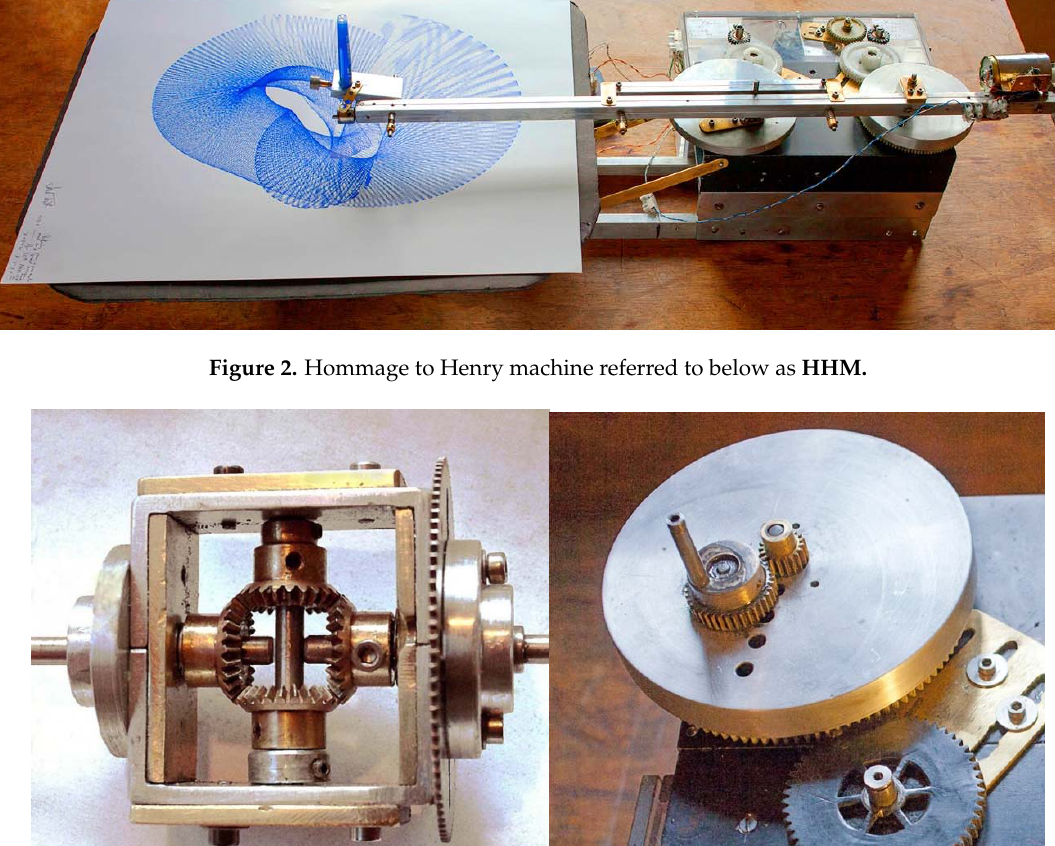
Figure 4. X:Y configuration, sun and planet on the left, elliptical turntable.